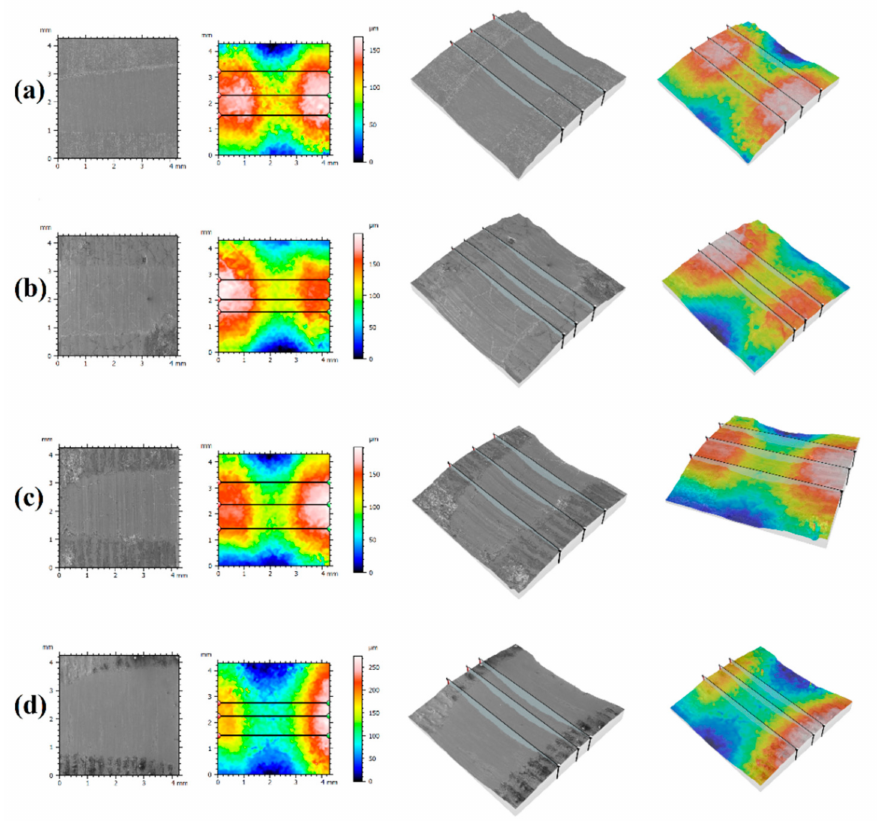
Figure 13. Surface topography after wear resistance tests for ( a ) diffusion borochromized layer, ( b ) B-Cr coatings produced using 600 W, ( c ) B-Cr coatings produced using 900 W, and ( d ) B-Cr coatings produced using 1200 W.